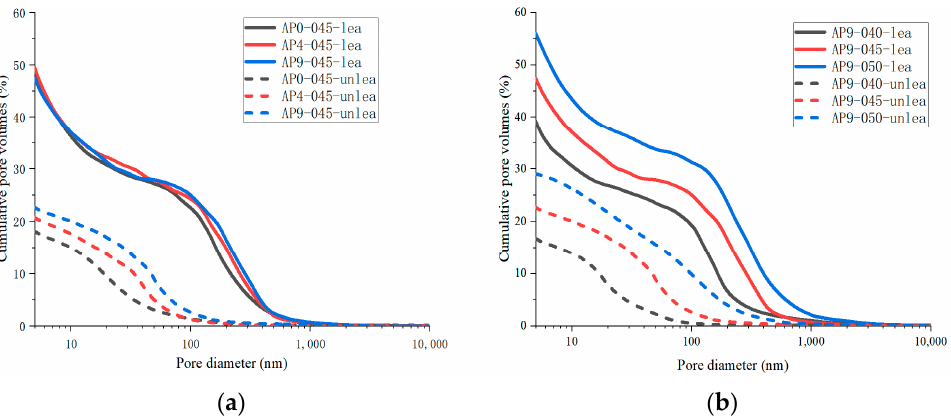
Figure 18. The porosity of the unleached and leached cement pastes: ( a ) different dosages of the AS accelerator; ( b ) different w / c .